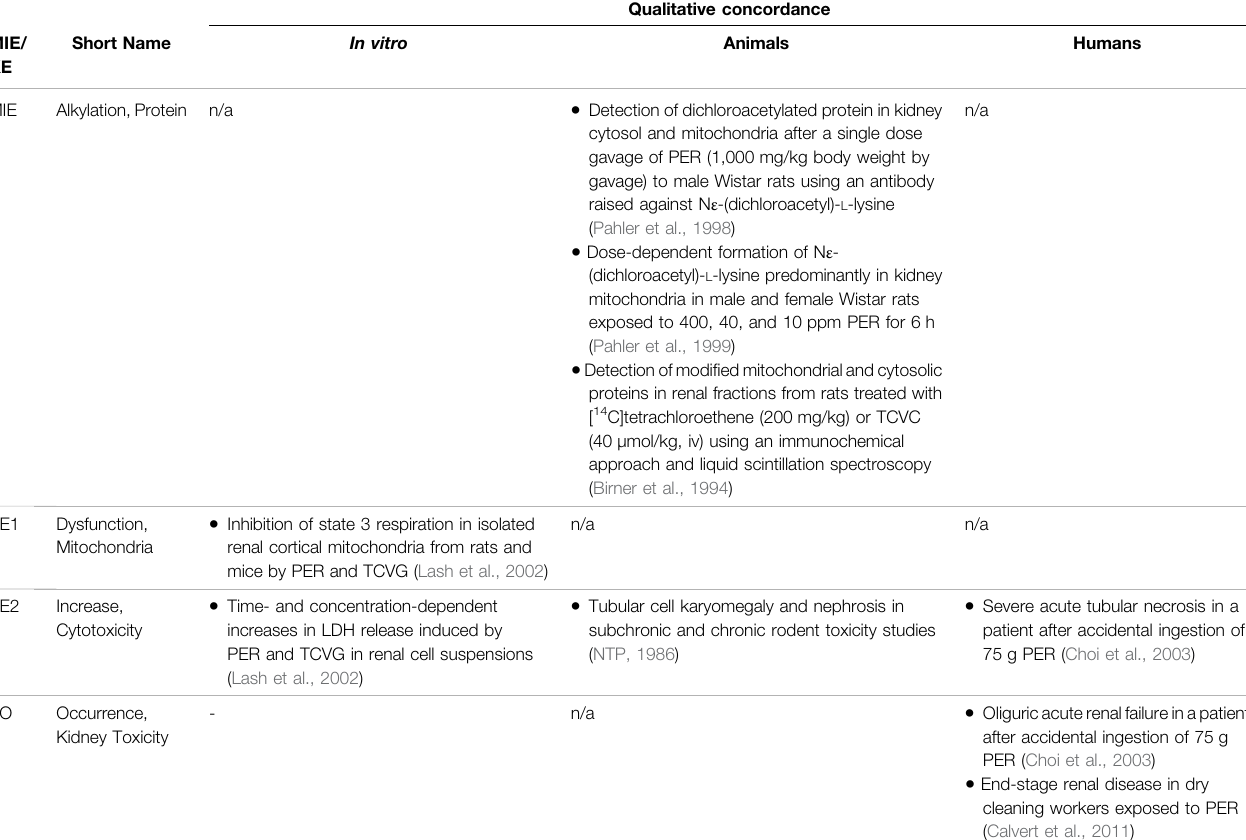
TABLE 7B | Evidence from human, animal and in vitro studies on perchloroethylene (PER) and its and its glutathione- and cysteine- S -conjugates TCVG and TCVC supporting the key events and qualitative concordance of KEs within this AOP (n/a = no data